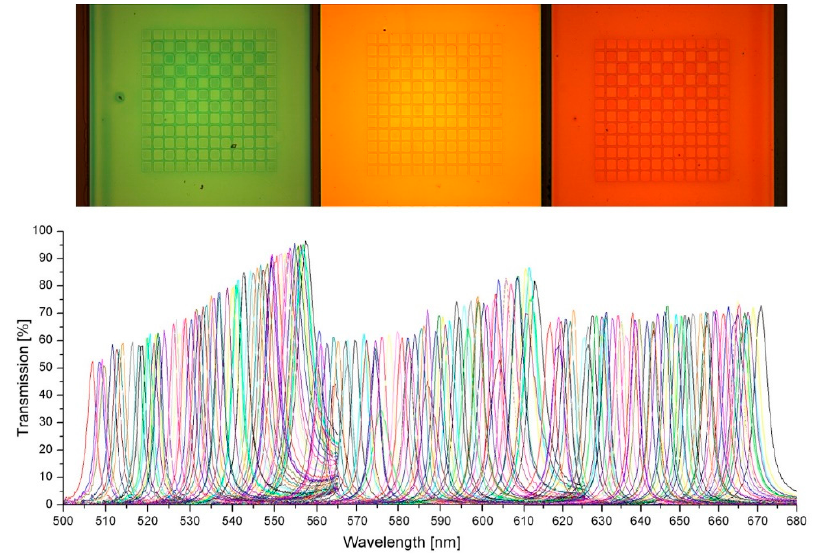
Figure 6. ( Top ) optical micrograph displaying three FP filter arrays and ( bottom ) related optical transmission spectra. Reprinted with permission from ref. [37]. Copyright 2018 Springer Applied Nanoscience.